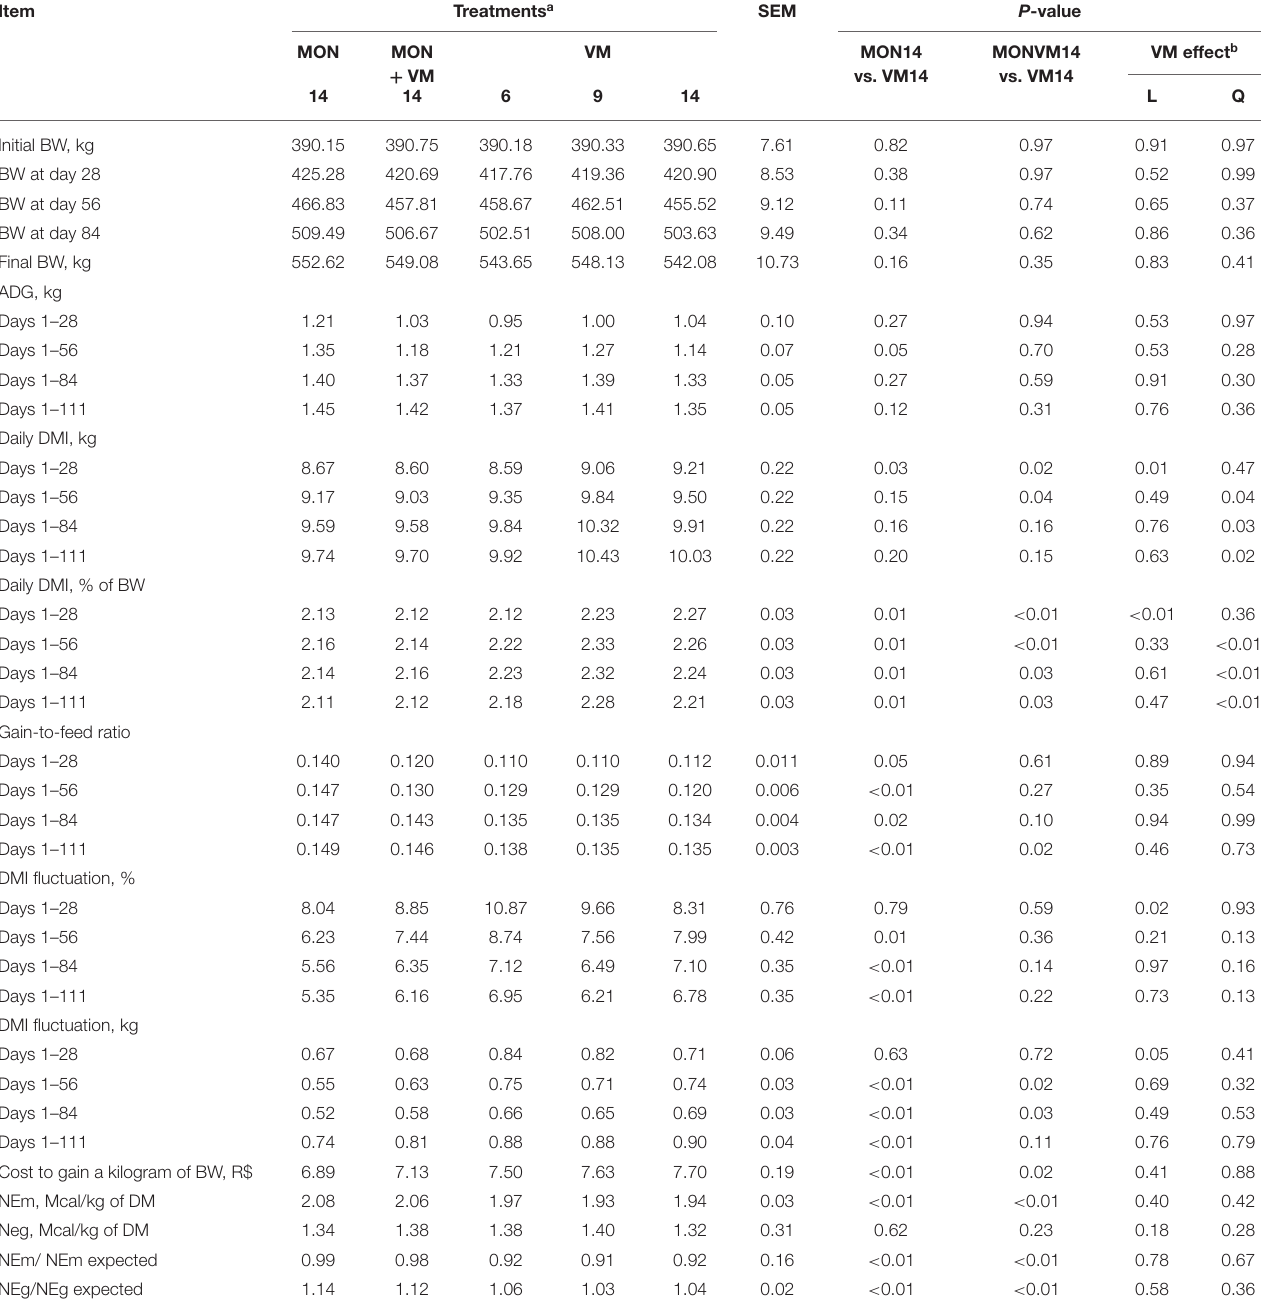
TABLE 2 | Feedlot performance of Nellore yearling bulls consuming high-concentrate diets containing sodium monensin (MON), virginiamycin (VM), or both during adaptation and finishing